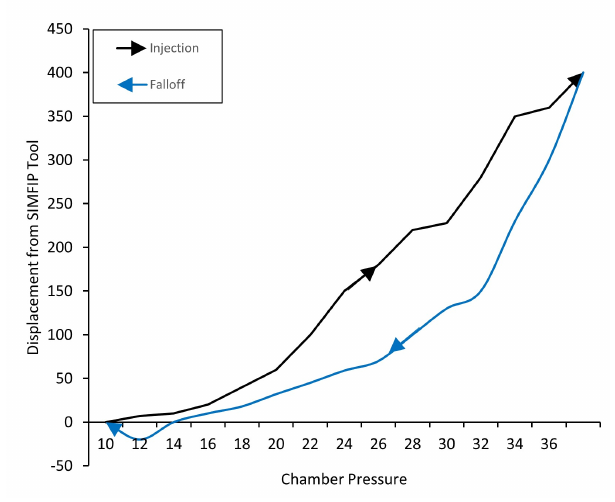
Figure 12. Sketch of SIMFIP tool reading versus pressure.